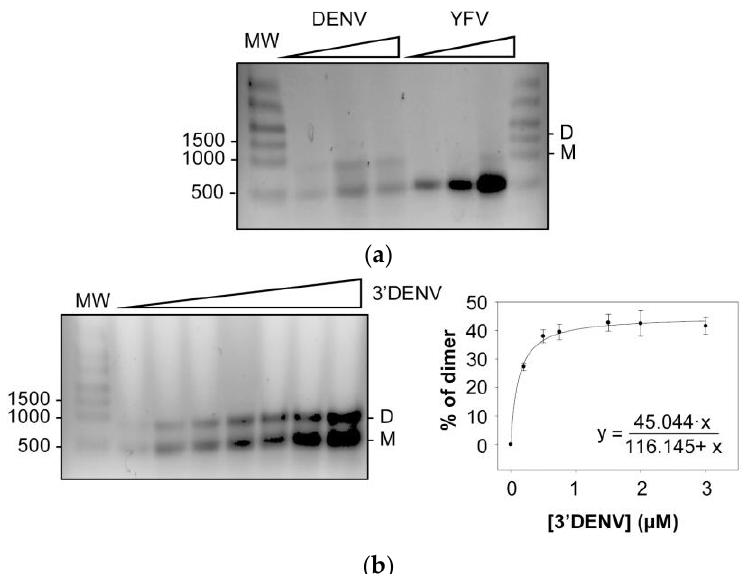
Figure 8. Dimerization of the genomic 3 ′ UTR of DENV. ( a ) The genomic 3 ′ UTRs of two flaviviruses that are closely related to WNV, DENV (3 ′ DENV) and YFV (3 ′ YFV), were subjected to dimerization assays. Conformers were resolved as noted in Figure 2. ( b ) Dimerization assay at increasing concen- trations of 3 ′ DENV RNA. Left panel: a representative image of these experiments. The percentage of dimers was quantified as described, and data were fitted to a non-linear equation (right panel). Values are the mean of three independent experiments ± standard deviation.